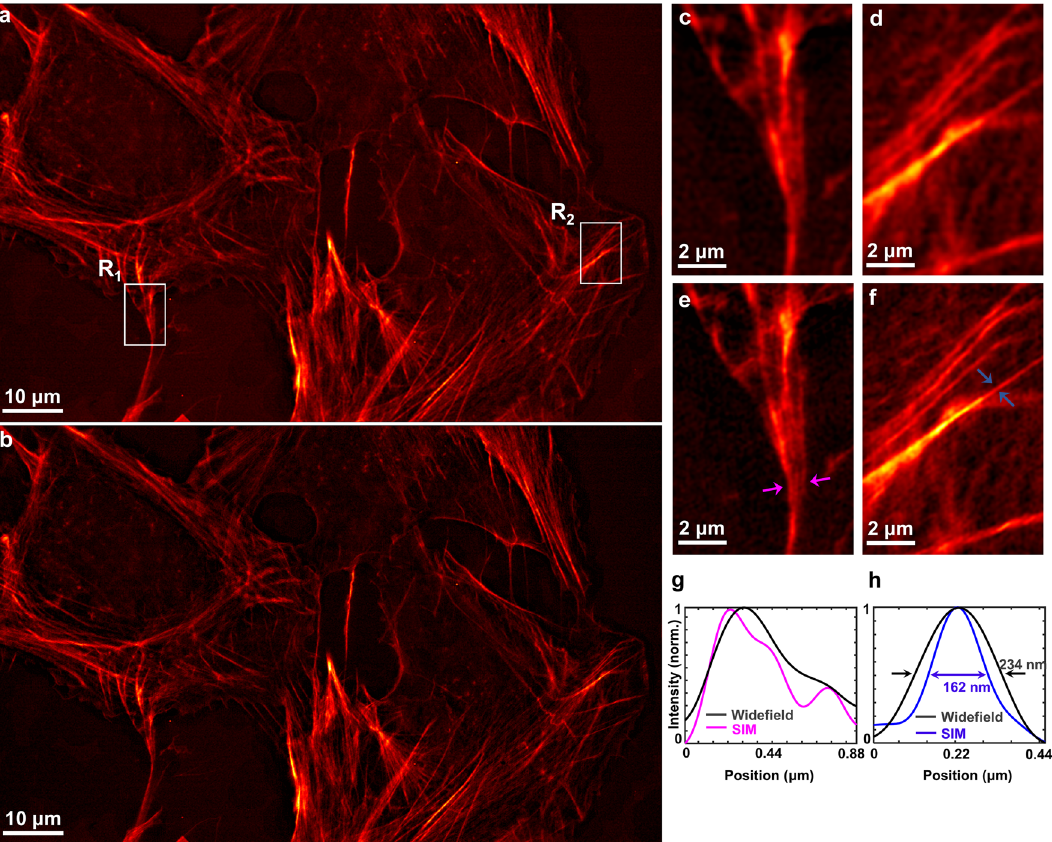
Figure 6. Experimental results of actin filaments of U2OS cell stained with alexa-fluor 532: ( a ) widefield image; ( b ) tSIM reconstruction image; ( c , d ) magnified widefield images of white box in R 1 and R 2 regions respectively; ( e , f ) closeup of the tSIM images in R 1 and R 2 regions respectively; ( g ) intensity line-profiles of ( c , e ) shown by magenta colour; ( h ) intensity line-profiles of ( d , f ) shown by blue colour.